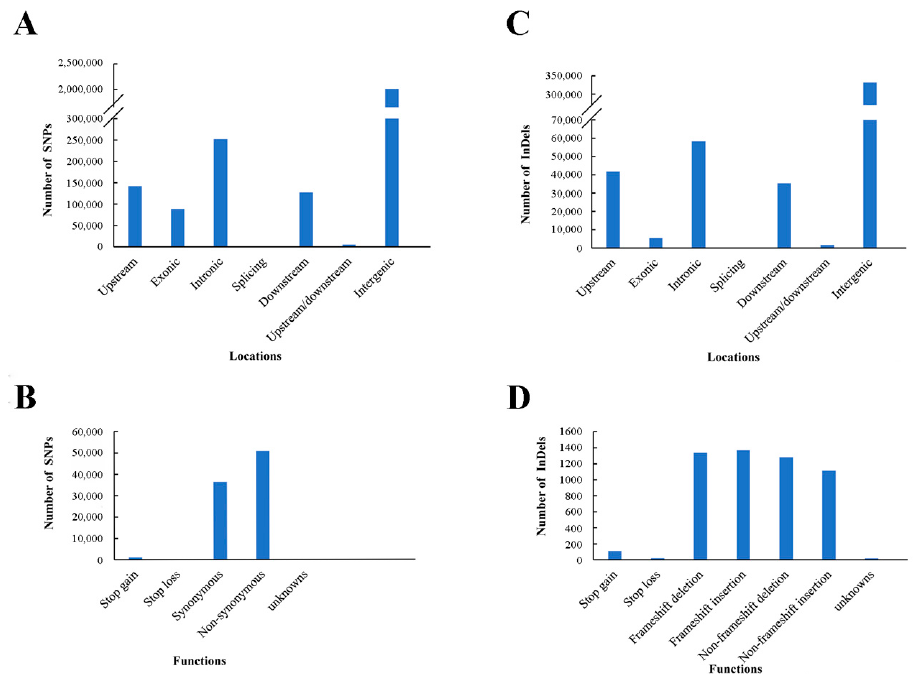
Figure 2. Statistics of the genomic loci of single-nucleotide polymorphisms (SNP) and InDel and their functional annotation. ( A ) Statistics of SNP genomic loci. ( B ) Statistics of SNP functional anno-